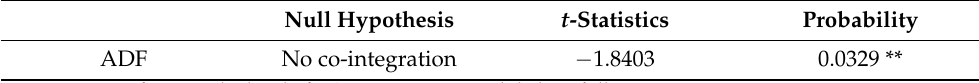
Table 4. Kao’s residual panel cointegration test results (ADF).